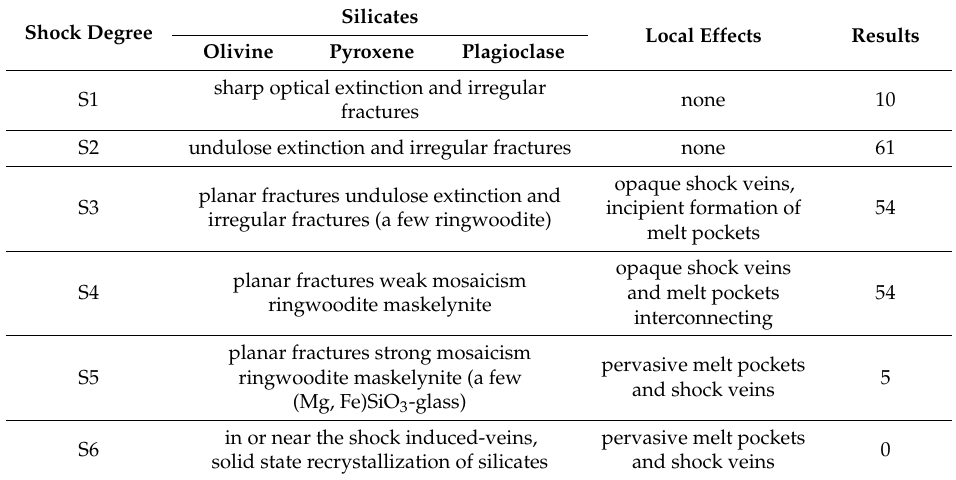
Table 1. Shock metamorphism degrees of Grove Mountains chondrites (based on the literature